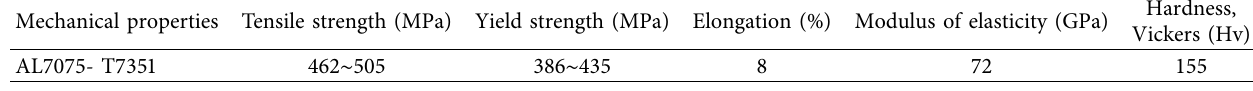
Table 1: Mechanical properties of